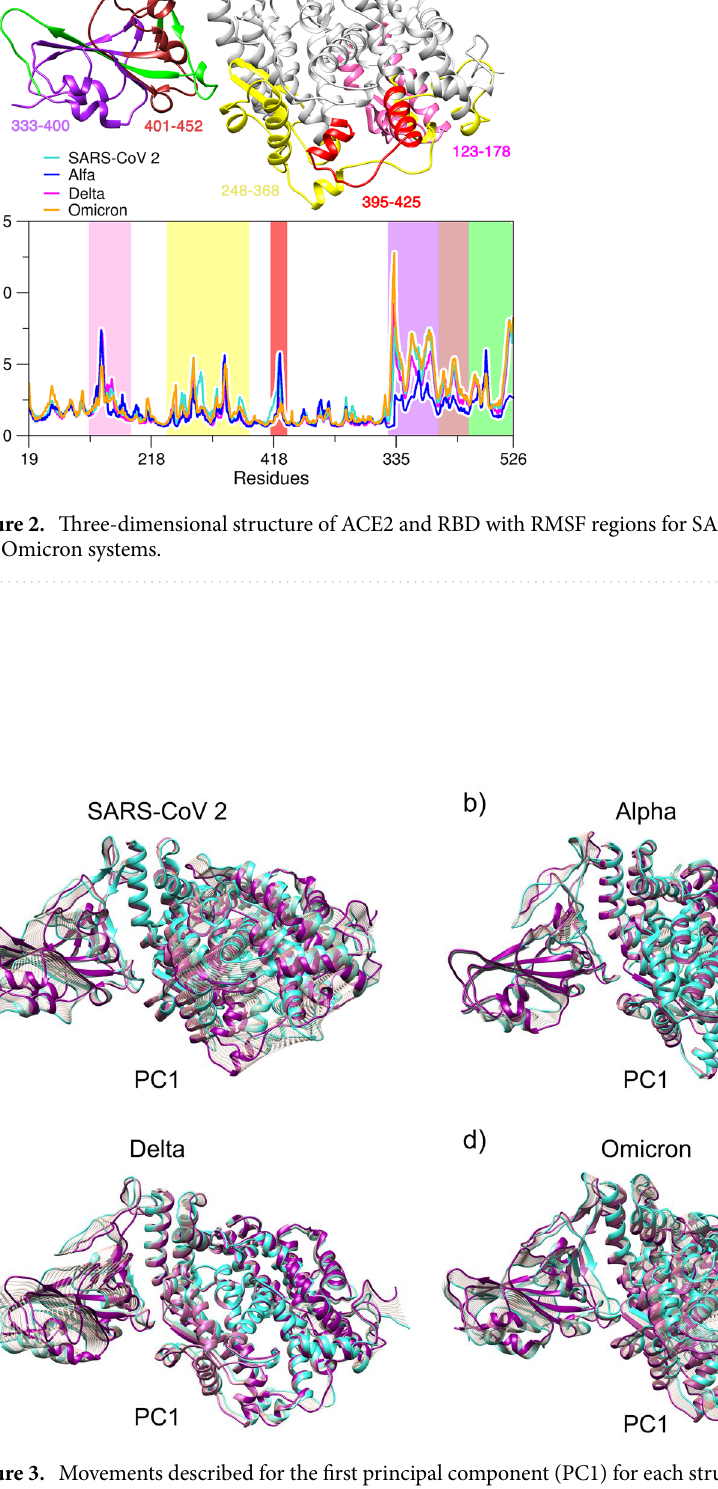
Figure 3. Movements described for the first principal component (PC1) for each structure of ACE2 and RBD. ( a ) Moving in PC1 to the RBD WT complex (SARS-CoV-2) and ACE2 receptor. ( b ) changes in PC1 to RBD Alpha and ACE2. ( c ) Change moving of PC1 to RBD Delta and ACE2. ( d ) Moving from PC1 to the complex between RBD Omicron and ACE2. In turquoise, the initial structure of the movement, in dark magenta, the final structure and in gray, the intermediate structures of the movement. The conformational dynamics were obtained from 200 ns of aMD